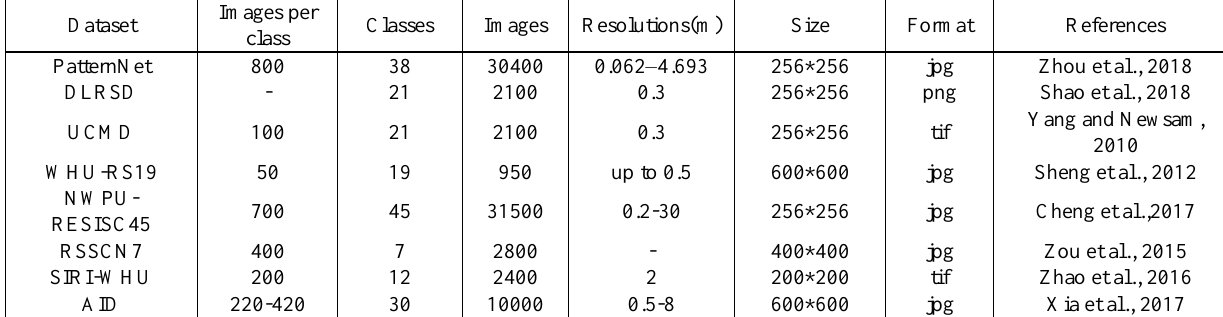
Table 1. Publicly available datasets applied in RSIR Table 1 lists several publicly available datasets which have been applied in RSIR. The maximum numbers for each class and all classes are 800 and 31500, respectively in the above